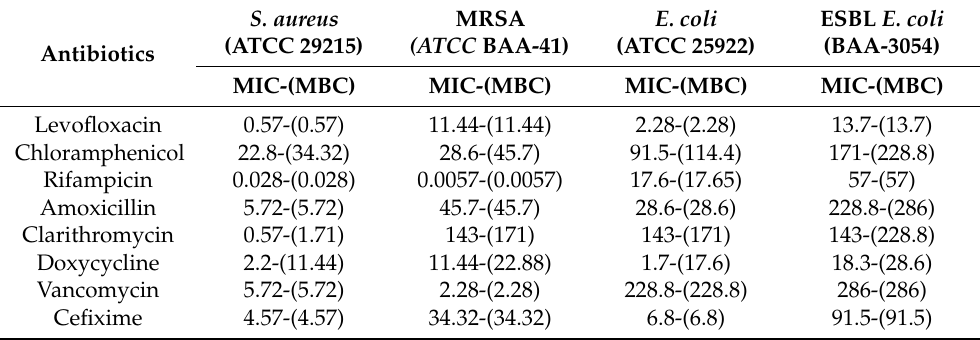
Table 3. The minimum inhibitory and minimum bactericidal concentrations ( µ g/mL) of the eight antibiotics against the tested bacterial